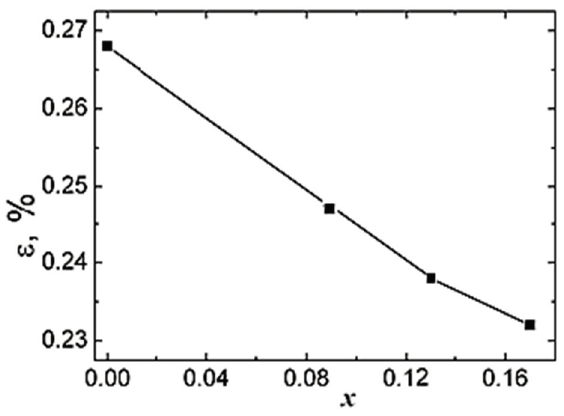
Figure 5. The dependency of microstrain, ε , on the concentration of Ce ions ( x